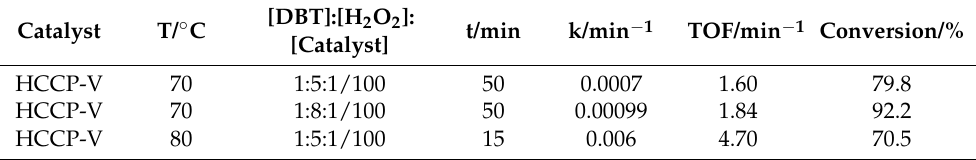
Table 2. The catalytic oxidation results of DBT by HCCP-V in CH 3 CN.